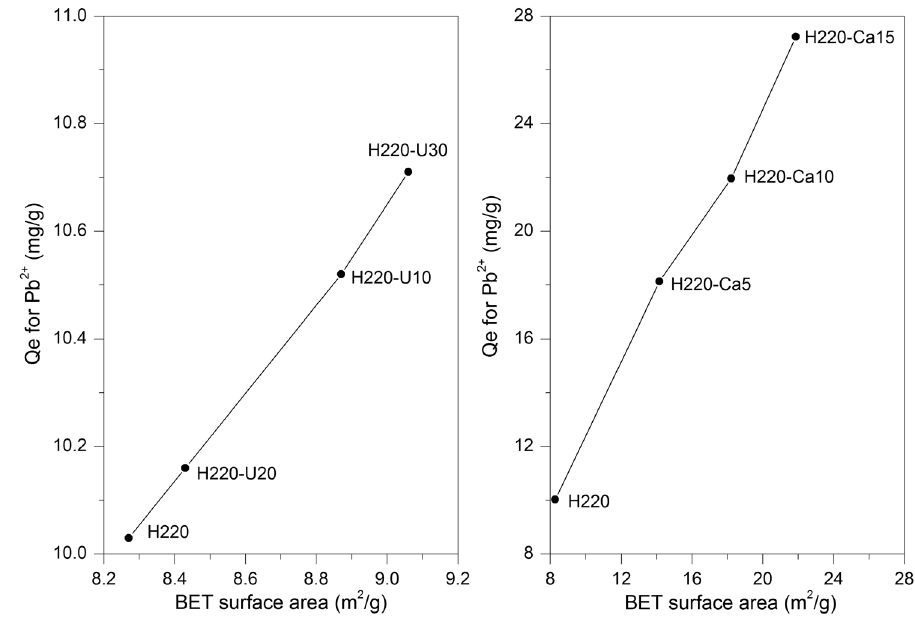
Figure 6: Relationship between the surface area and adsorption capacity of